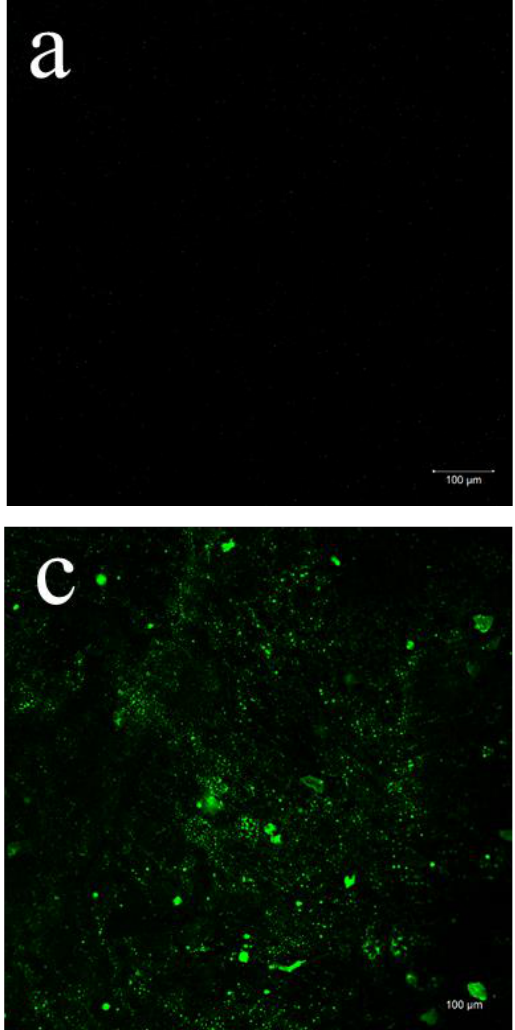
Figure 2. SEM observations of cross-sections of F0/0 ( a ), F5/0 ( b ), F5/0.25 ( c ), F5/0.5 ( d ), F5/1 ( e ), F5/2 ( f ), F5/5 ( g ) and F5/10 ( h ) films at 200× magnification.